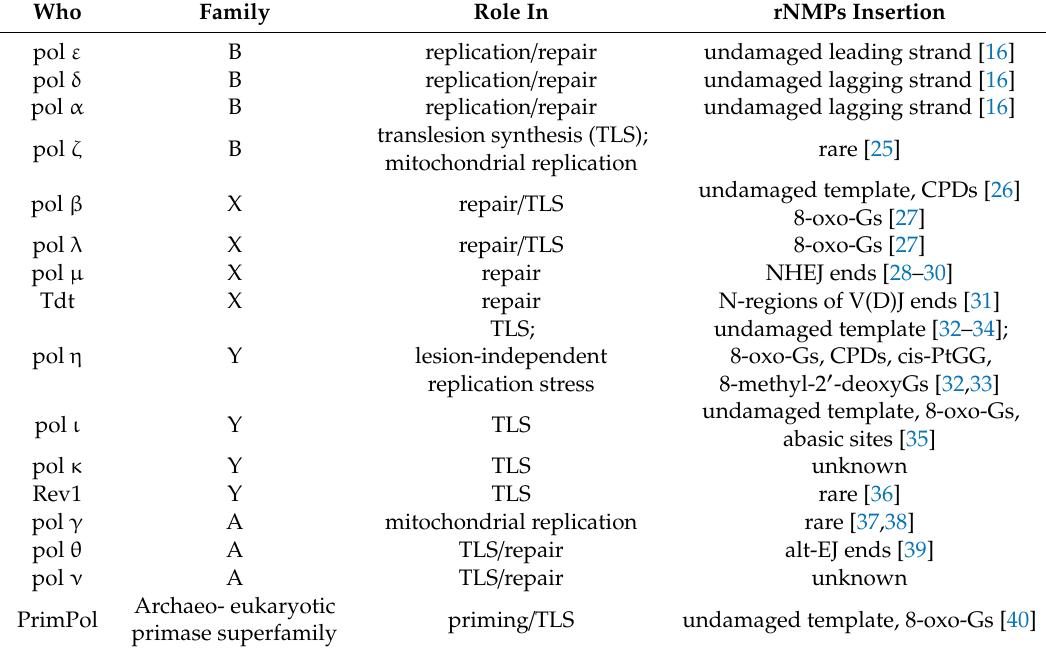
Table 1. Ribonucleoside monophosphates (rNMPs) insertion by eukaryotic DNA polymerases opposite di ff erent DNA templates. Eukaryotic DNA polymerases are classified according to family type and roles in DNA transactions; their ability to synthesize ribonucleotides opposite di ff erent types of DNA templates is then